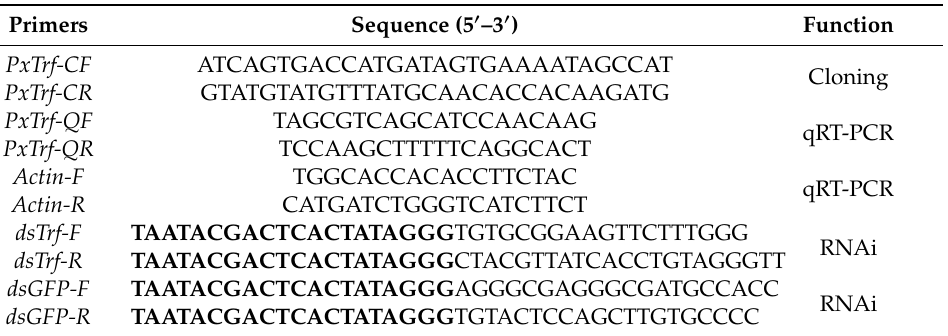
Table 1. Nucleotide sequences of primers used in this